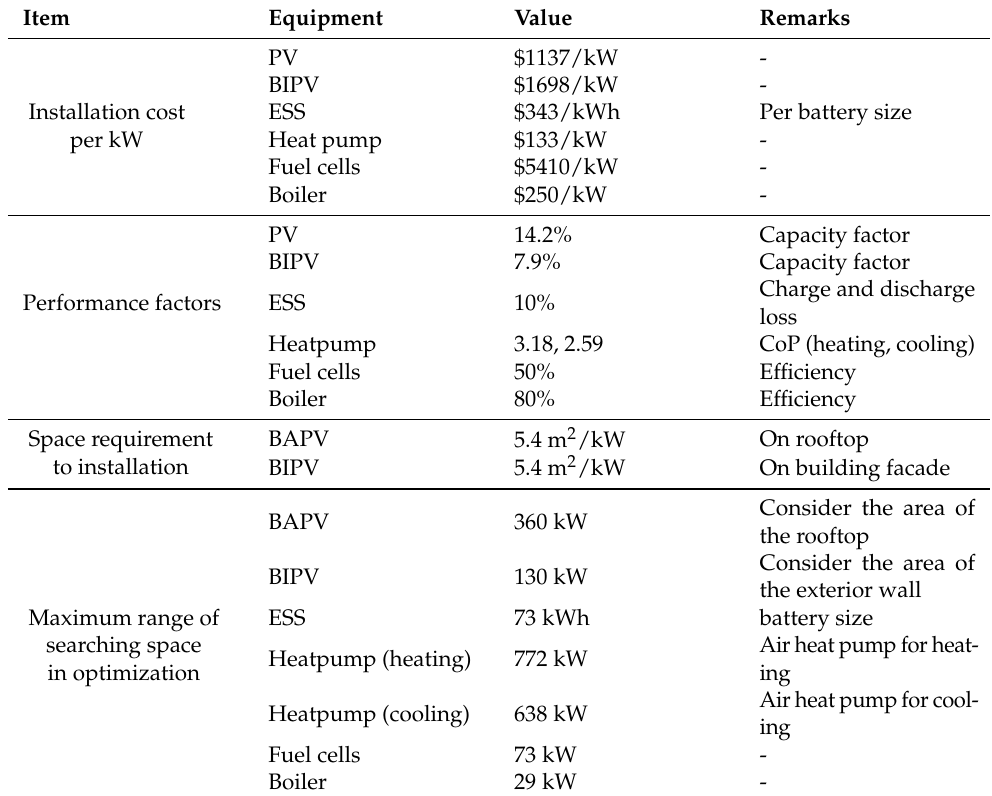
Table 7. The information on the energy supply equipment to be installed in the building.